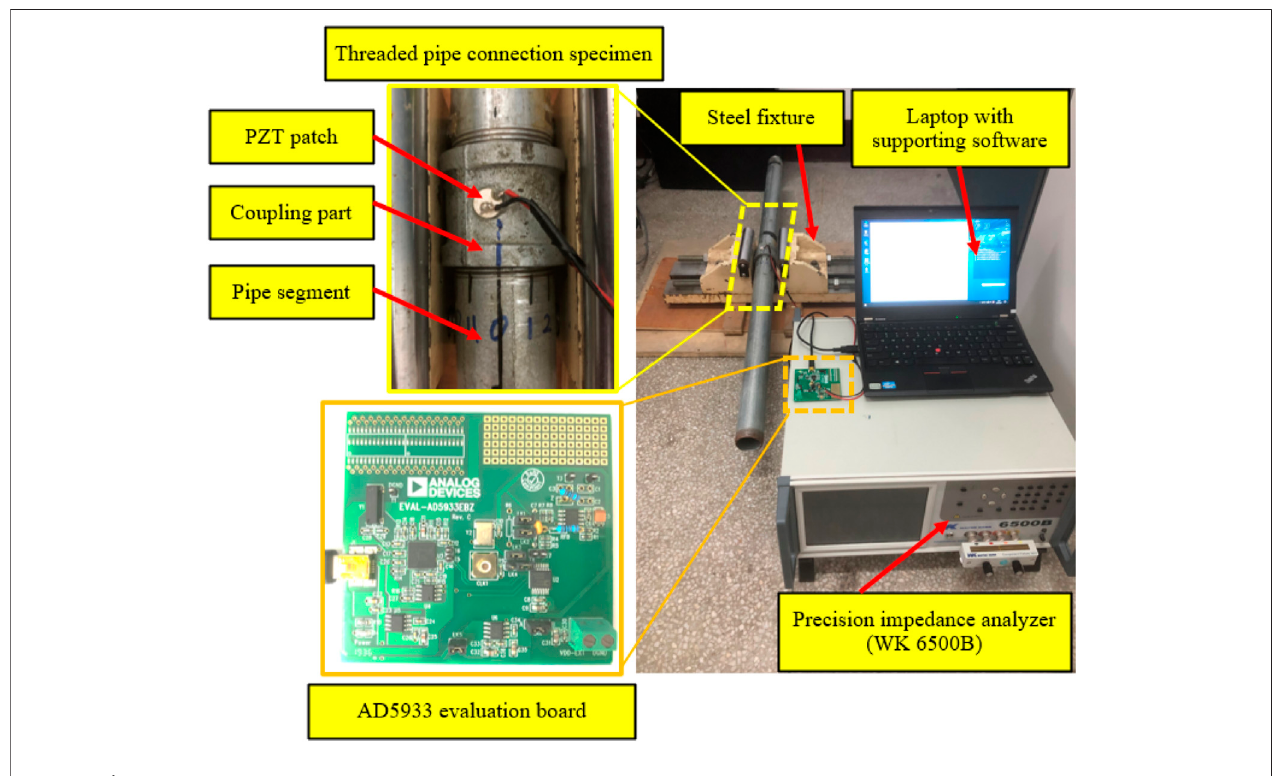
FIGURE 3 | Experimental